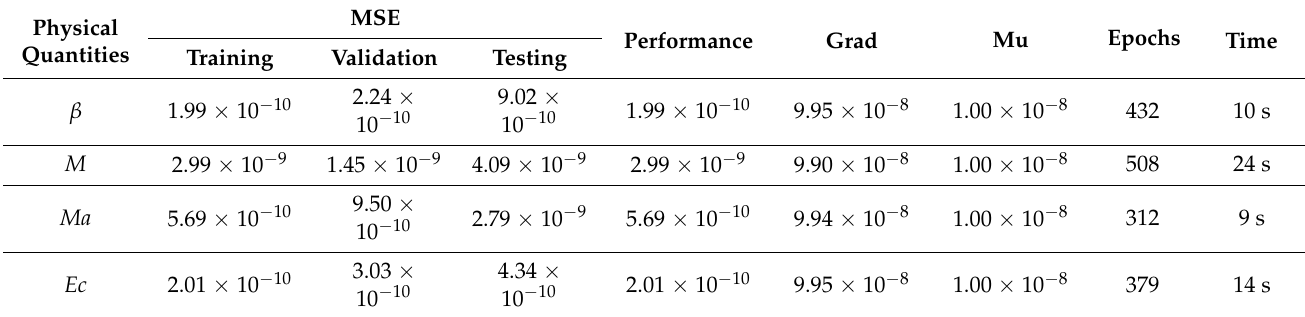
Table 3. Outcomes of LMT-ABPNN for variants of θ ( η ) of MHD-SGFM.